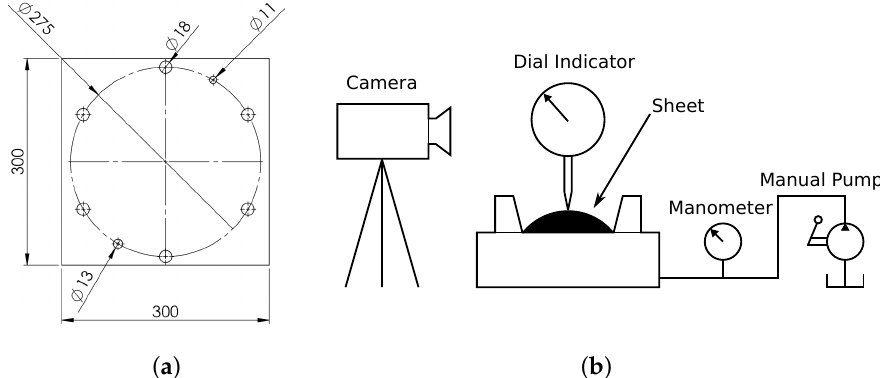
Figure 3. Bulge test ( a ) specimen (dimensions in mm) and ( b )